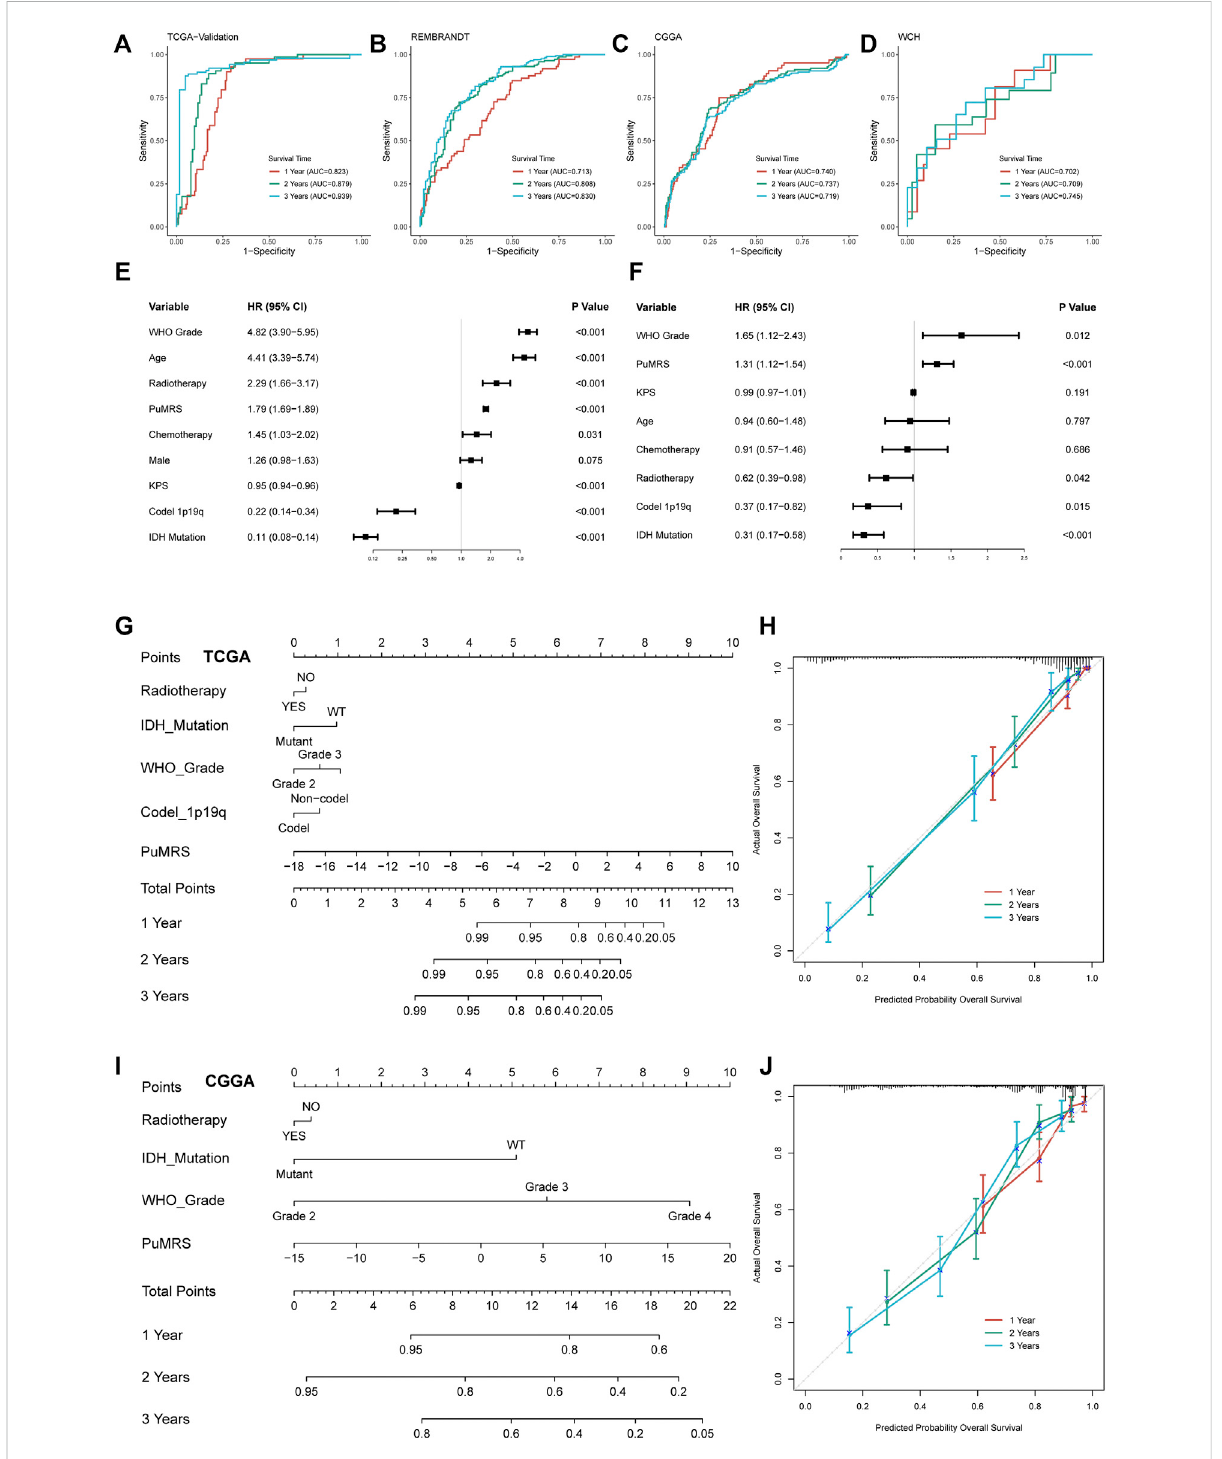
FIGURE 7 Prognostic value of PuMRS and construction of PuMRS-based nomograms. ROC curves and matched AUC of 1-, 2-, and 3-year survival in (A) TCGA validation set, (B) CGGA cohort, (C) REMBRANDT cohort, and (D) WCH cohort. (E) Univariate and (F) Multivariate Cox regression analysis of potential prognostic factors in overall survival of glioma. Nomogram of 1-, 2-, and 3-year survival of glioma patients based on (G) TCGA cohort, (I) CGGA cohort. Calibration plots of the nomogram based on (H) TCGA cohort and (J) CGGA